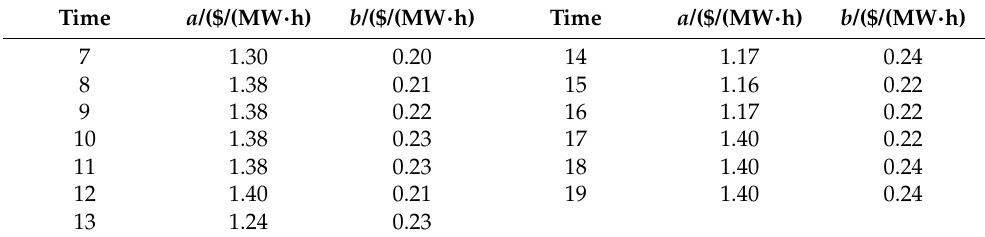
Table A5. Quotation factor for PV producer 5.